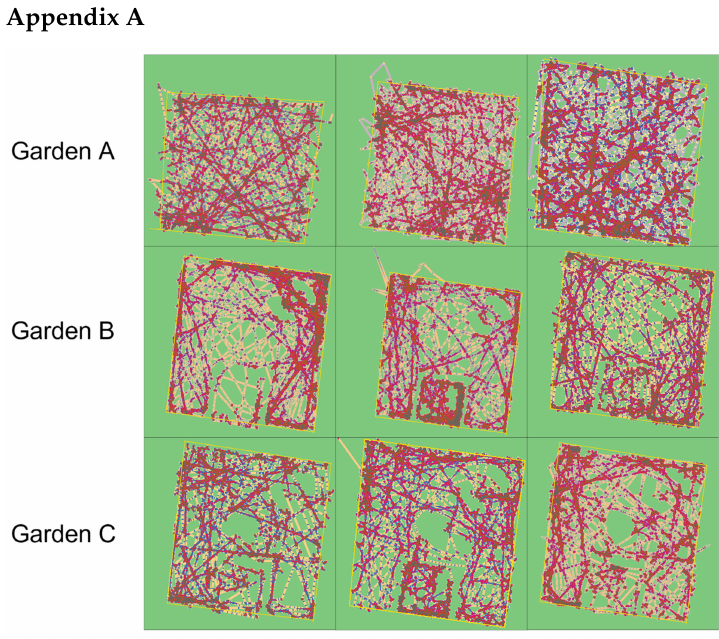
Figure A1. Trampling analysis output from the custom-built software showing colorimetric maps of the three garden designs studied in this